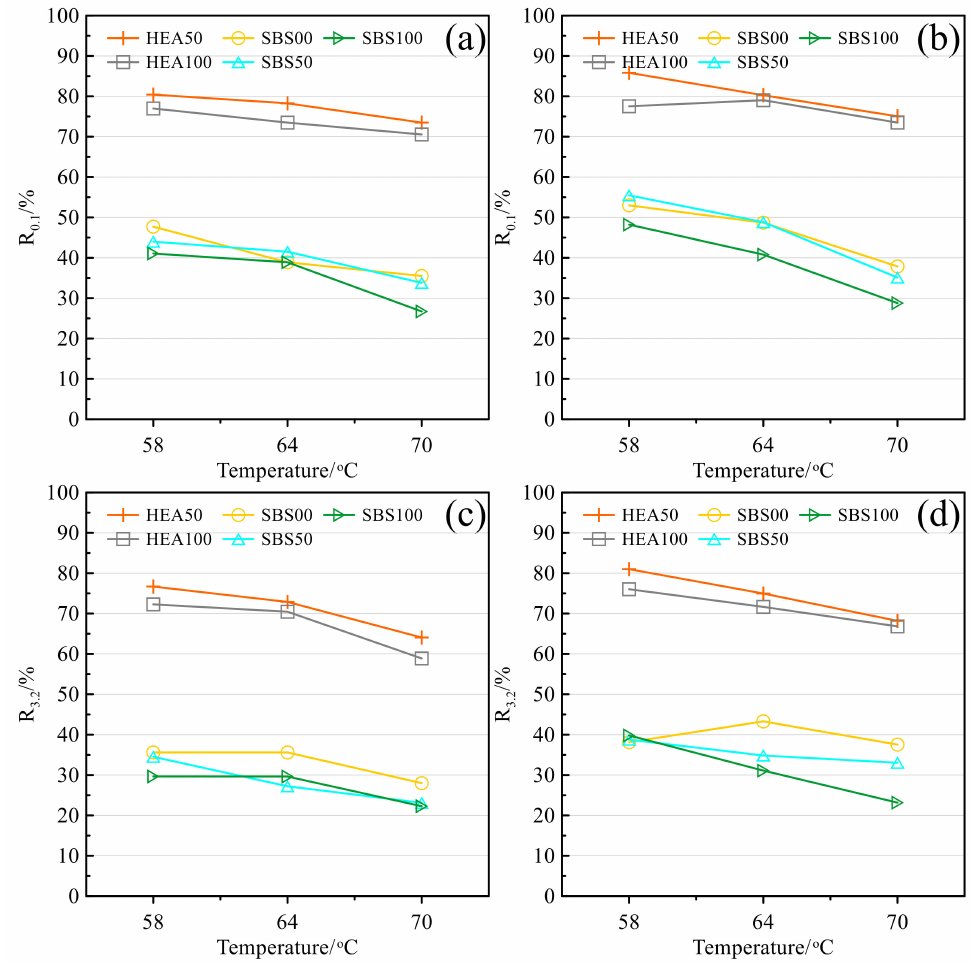
Figure 11. Recovery rate: ( a ) 0.1 kPa before TFOT; ( b ) 0.1 kPa after TFOT; ( c ) 3.2 kPa before TFOT; ( d ) 3.2 kPa after